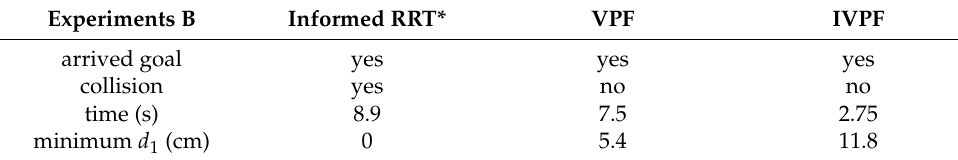
Figure 8. Experiments B: the distance between the robot arm and the target point and obstacles in the simulation experiments. ( a – c ) The results of the three algorithms. ( a ) informed RRT*; ( b ) VPF; ( c ) IVPF. Table 4. The result of static obstacles avoidance experiment